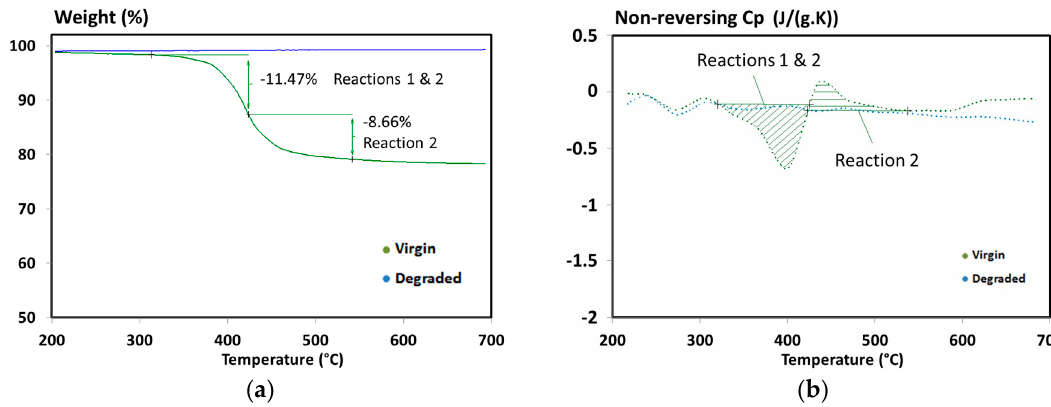
Figure 4. ( a ) Remaining mass; and ( b ) non-reversing specific heat capacity obtained during a simultaneous thermal analysis carried out under nitrogen to determine the heats of decomposition of T700/M21 [6].